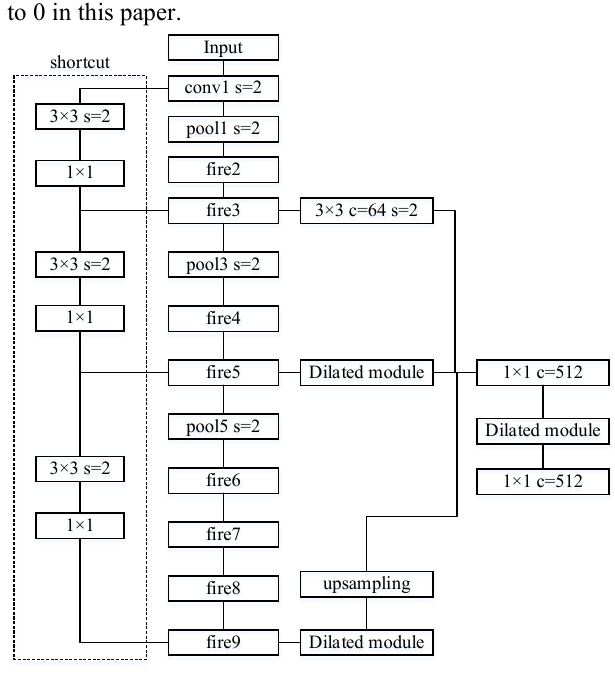
Figure 4. DR module